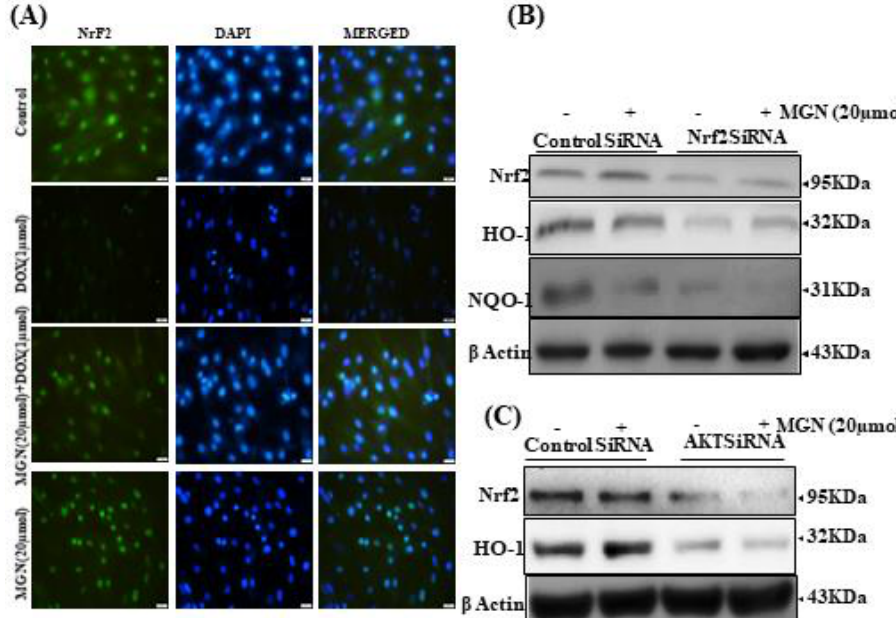
Figure 6. Pretreatment with MGN protects endothelial cells from DOX-induced apoptosis. For the study, the control HUVECs and pretreated cells (20 µ M MGN for 24 h) and/or DOX. ( A ) Immunofluorescence analysis (200 × magnification) was used to evaluate the nuclear translocated Nrf2 expression. ( B ) HUVECS were transfected with a specific siRNA against Nrf2 or a control siRNA. Western blot analysis measured Nrf2, HO-1, and NQO-1 protein levels in cells transfected with control siRNA or siNrf2. ( C ) HUVECs were transfected with a specific siRNA against AKT or a control siRNA. The Western blot analysis measured Nrf2 and HO-1 (24 h) protein levels in cells transfected with control siRNA or siAKT. HUVECs were treated with MGN (20 µ M) for the indicated time.